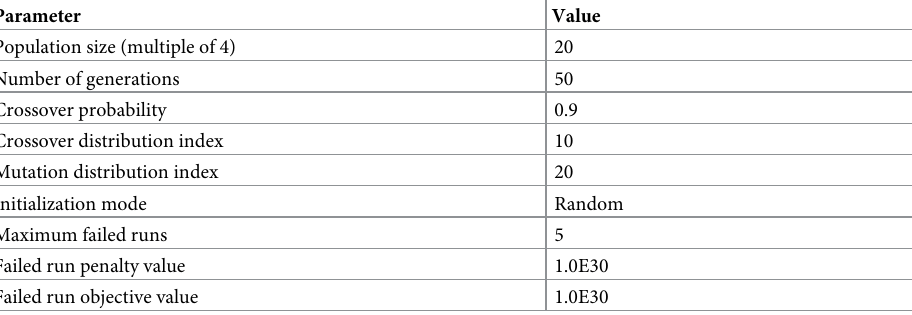
Table 5. Parameter definitions for the NSGA-II